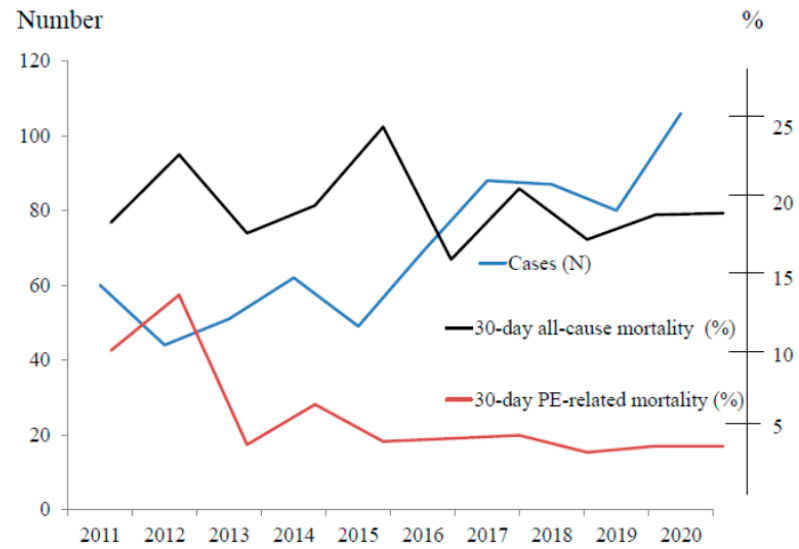
Figure 1. Number of APE Cases ( n ) and Mortality Rate (%) during 2011–2020.